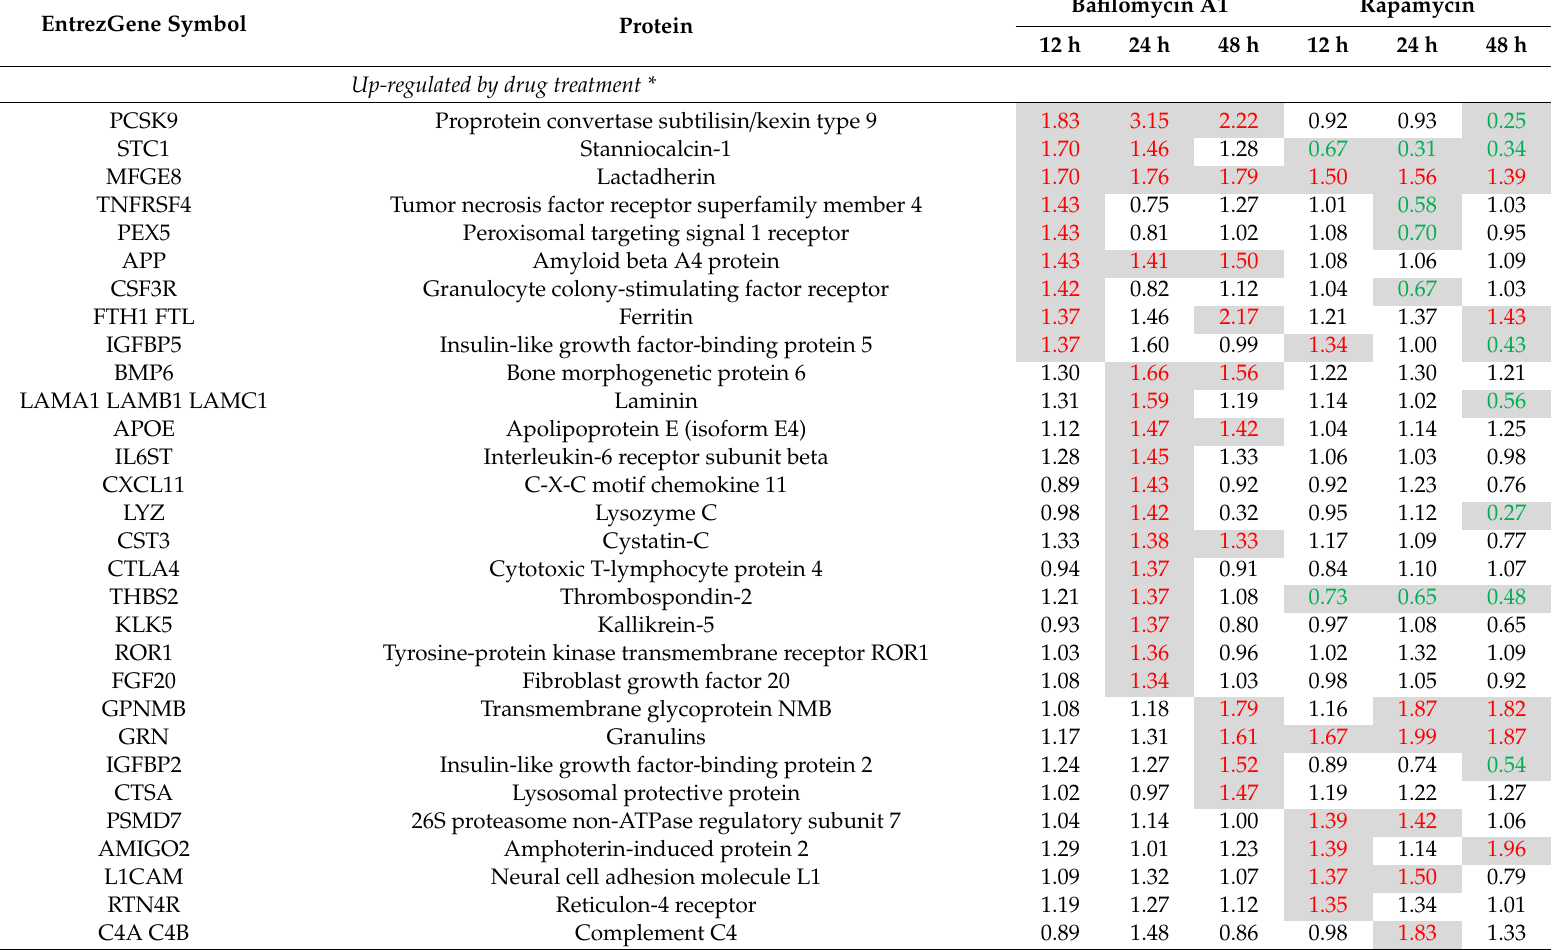
Table 2. U-251 proteins significantly dysregulated by Bafilomycin A1 or